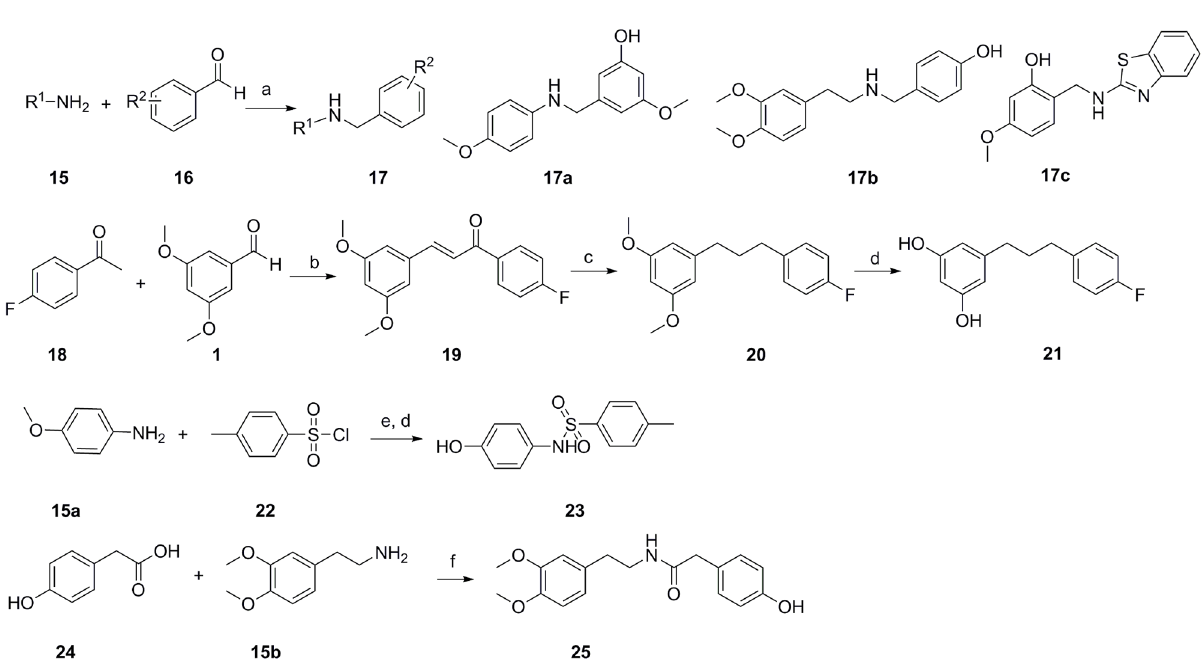
Fig 2. Synthesis of 17, 21, 23, and 25. Reagents and conditions: a. TsOH, ethanol; 0°C, NaBH 4 ; b. K 2 CO 3 , ethanol; c. Pd/C, H 2 , RT, 12 h; d. BBr 3 , CH 2 Cl 2 , -20°C, 2 h; RT, 4 h. e. Et 3 N, CH 2 Cl 2 ; f. 180°C, neat, N 2 .